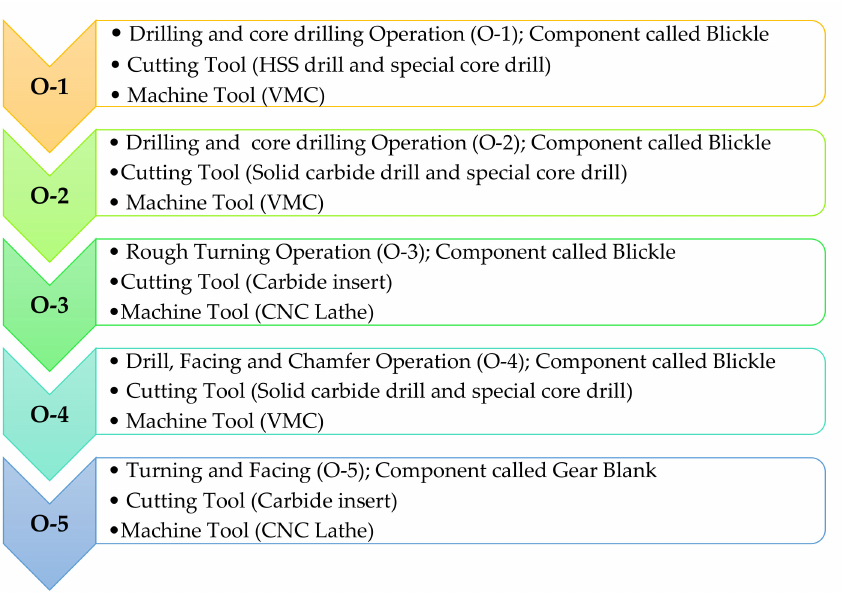
Figure 1. Machining operation details identified for study in the machine shop of the